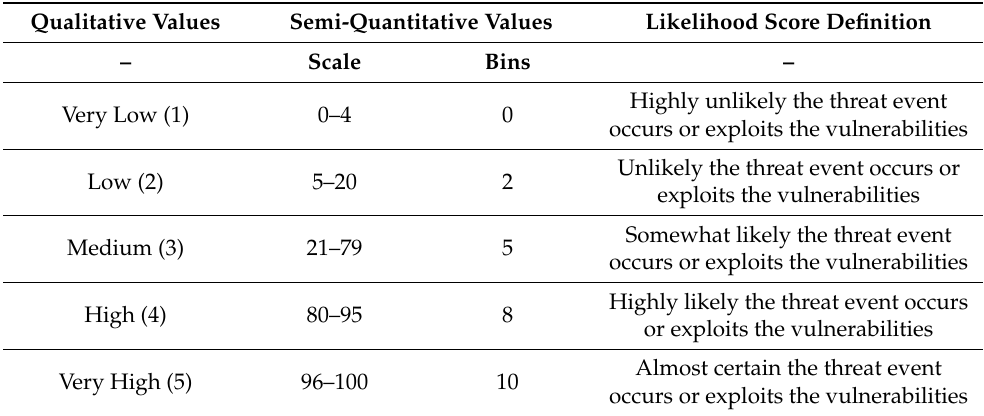
Table 7. Assessment scale for likelihood.